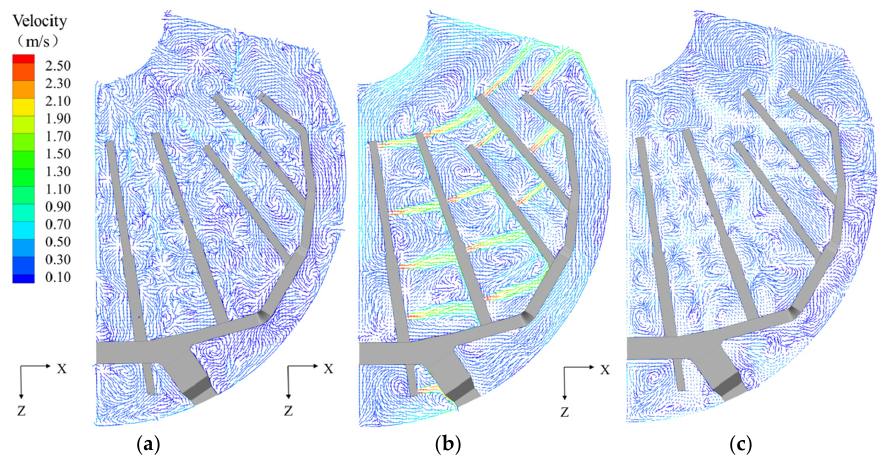
Figure 10. Velocity vector diagram of plenum at y = 0.71 m. ( a ) case B, ( b ) case C, ( c ) case D.